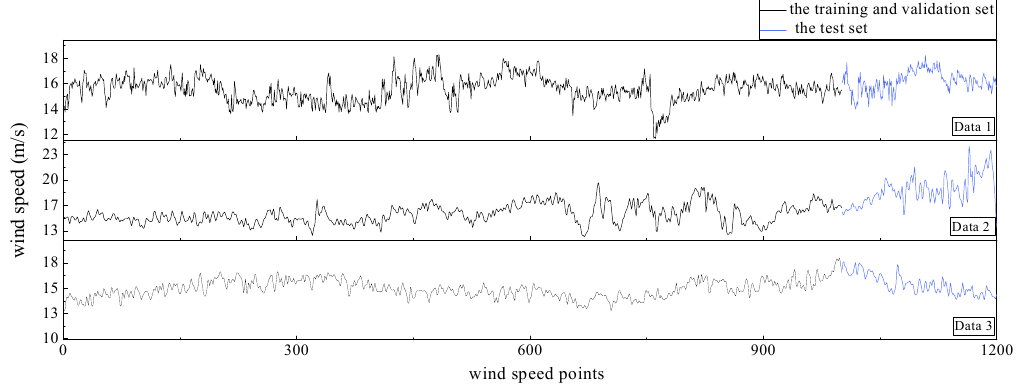
Figure 3. Wind speeds measured along three bridge segments.